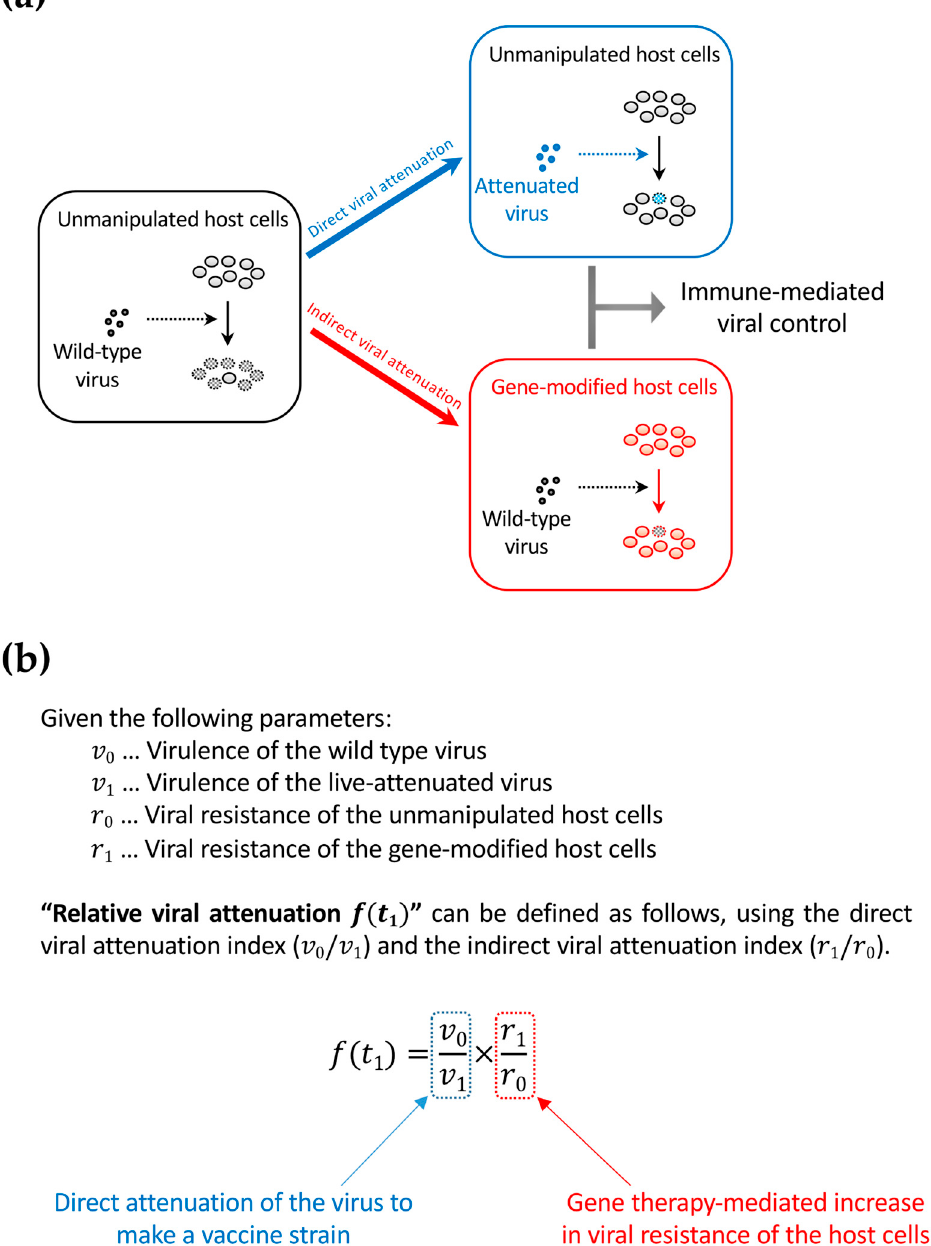
Figure 4. The concept of relative viral attenuation. ( a ) A schema describing direct and indirect viral attenuation. HIV usually infects host CD4 + cells efficiently and replicates rapidly. As a result, the host immune system fails to control viral replication (left). However, accumulating evidence in macaque AIDS models suggests that a live-attenuated virus, which infects and replicates slowly because of partial defects in the viral genome, can be controlled by the immune system and helps in further immunization against a potential superinfection with immunodeficiency virus strains that are homologous to the vaccine strain (upper right). The live attenuation method cannot be directly applied to HIV infection in humans because of safety concerns. However, indirect viral attenuation can be achieved by rendering the host cells HIV-resistant by an “intracellular immunization” gene therapy (lower right); ( b ) The definition of relative viral attenuation. This idea can connect live-attenuated vaccine studies and gene therapy approaches to achieve a functional cure. While live-attenuated HIV vaccines are not testable in humans for safety concerns, functional-cure gene therapy could be an alternative.